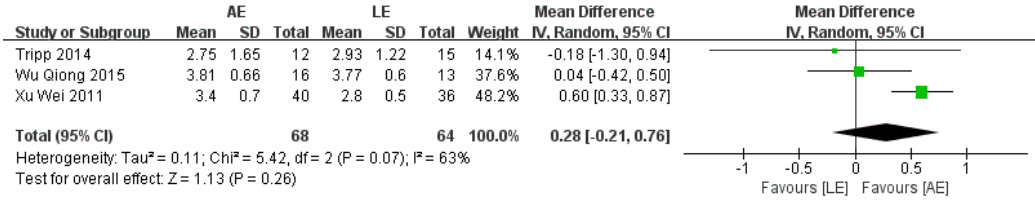
Figure 6. Forest plot: effects of FAC.